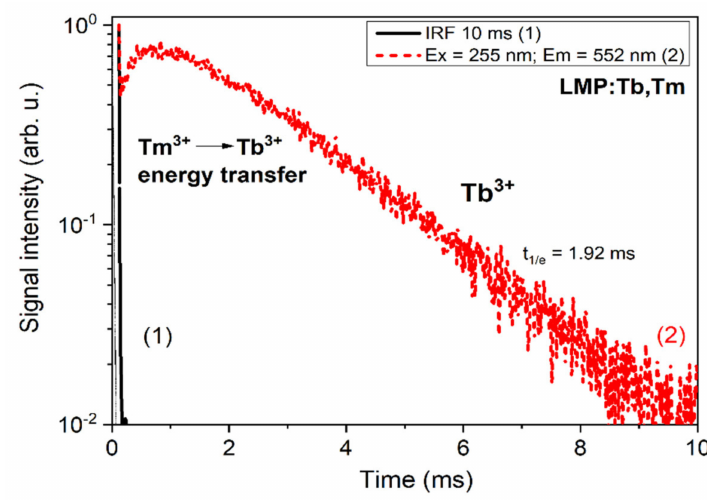
Figure 9. The luminescence decay kinetics of Tb 3 + ions at 552 nm under excitation in the respective excitation band of Tm 3 + ions. The instrumental response function (IRF) is also